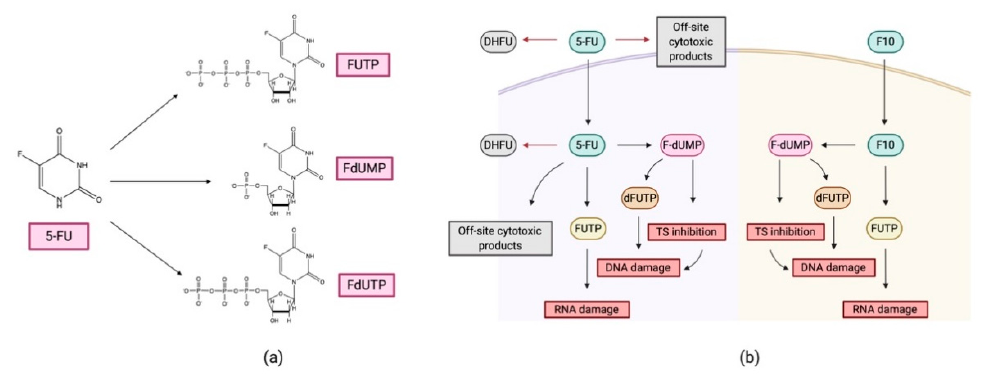
Figure 3. The anti-metabolite drug 5-fluorouracil (5-FU) . ( a ) Catabolism of 5-FU to triphosphate 5-fluorouridine (FUTP), 5-fluoro-2'-deoxyuridine monophosphate (FdUMP), and 5-fluoro-2'-deoxyuridine triphosphate (FdUTP). ( b ) Schematic of uptake and important metabolites of 5-FU and F10 mechanisms interfering with DNA and RNA replication.